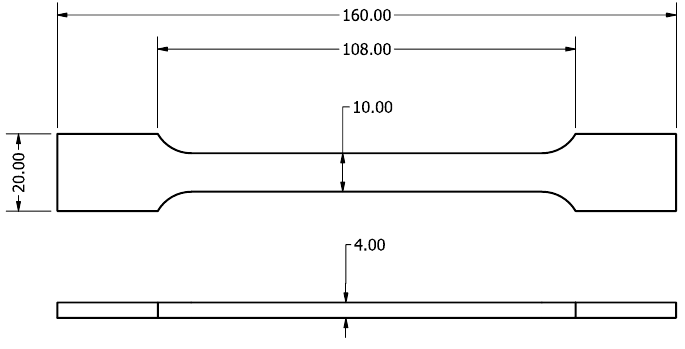
Figure 4. Sample dimensions.